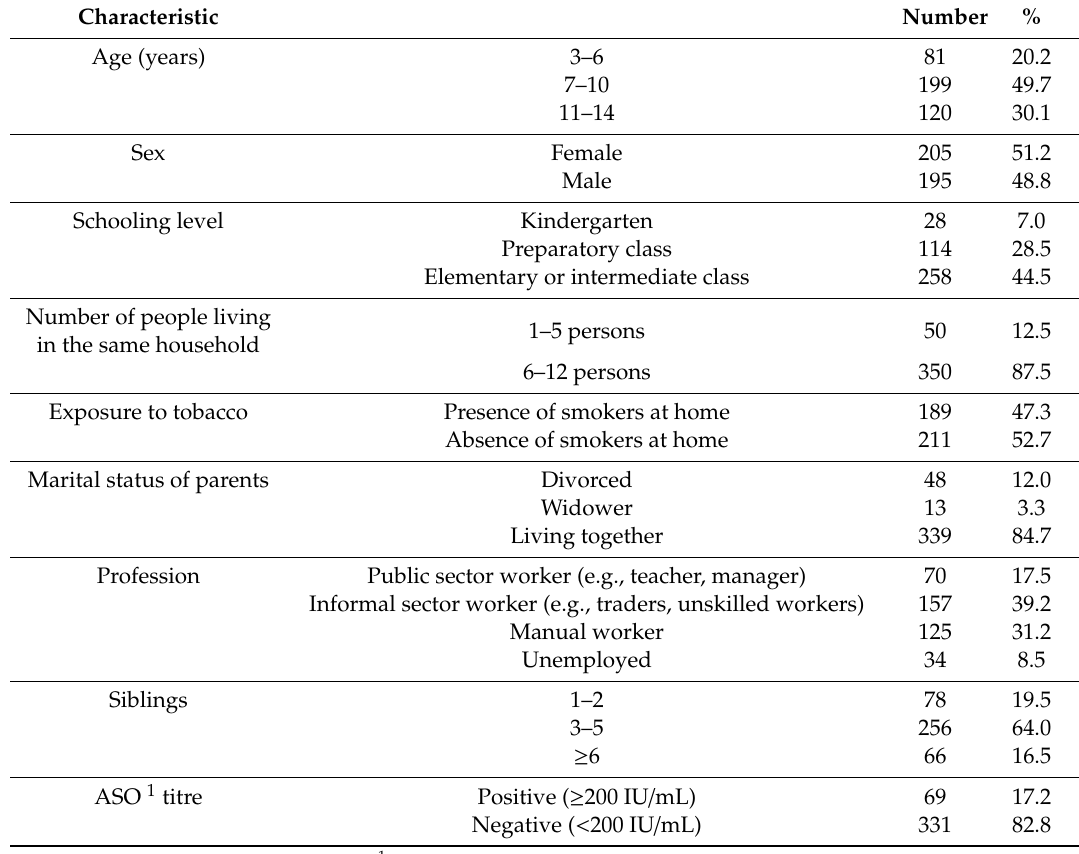
Table 1. Baseline characteristics of 400 children participating in this study pertaining to oropharyngeal carriage of beta-haemolytic streptococci in Bouak é , central C ô te d’Ivoire in March 2017.